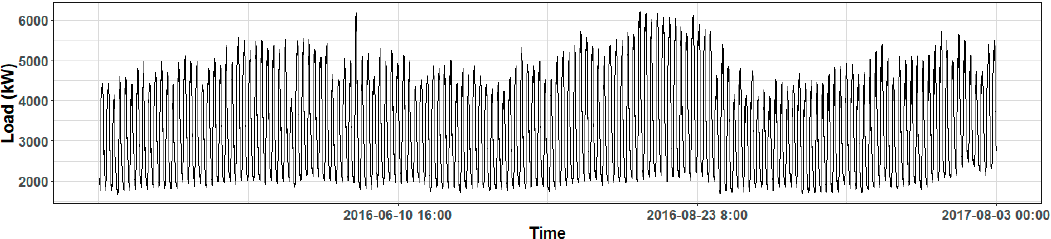
Figure 3. The 15-min interval train load data used during the summer at Inha University.